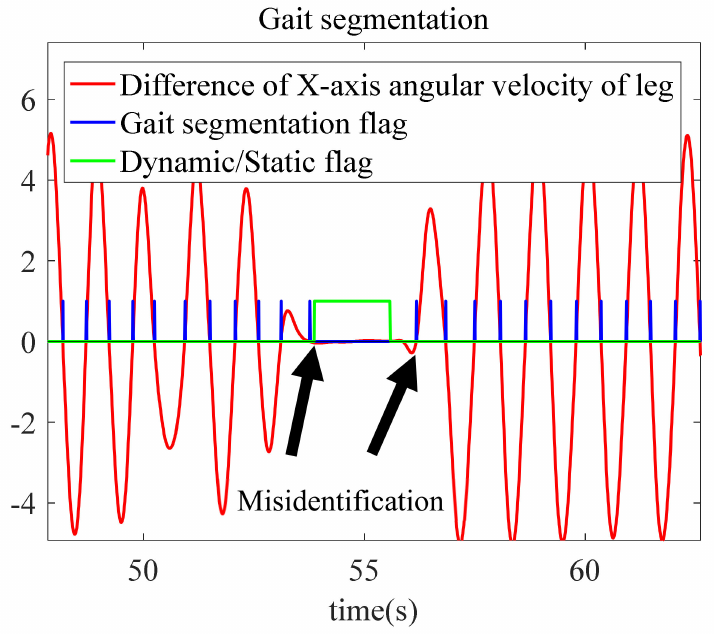
Figure 14. Diagram of gait